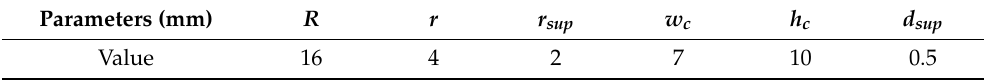
Table 1. Parameters used in the calculation estimation and FEA simulation.